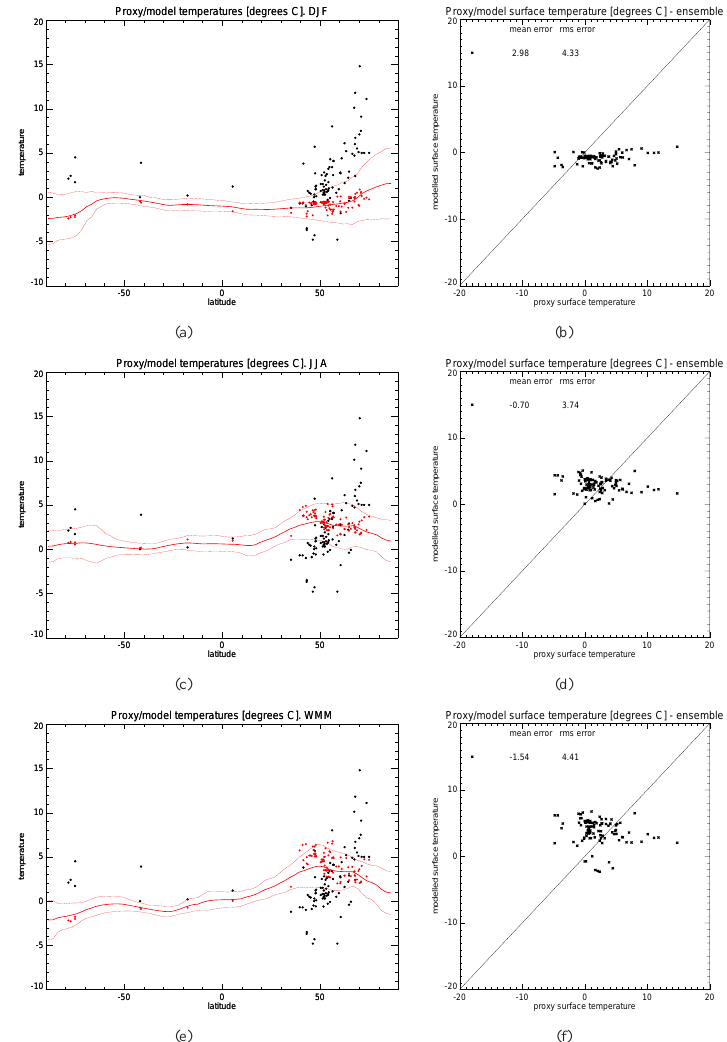
Fig. 8. Comparison of ensemble mean surface air temperature change, LIG minus pre-industrial, with data from Turney and Jones (2010). (a, c, e) Latitudinal distribution of data (black dots), compared with the ensemble mean model (red dots, from the same locations as the proxy data), with the zonal model ensemble mean (thick red line), and ± 1 standard deviation of the zonal model ensemble mean (thin red lines). (b, d, f) Modelled ensemble mean temperature vs. proxy data temperature for each terrestrial site in the Turney and Jones (2010) dataset. (a, b) are for DJF, (c, d) are for JJA, and (e, f) are for WMM. All units are ◦